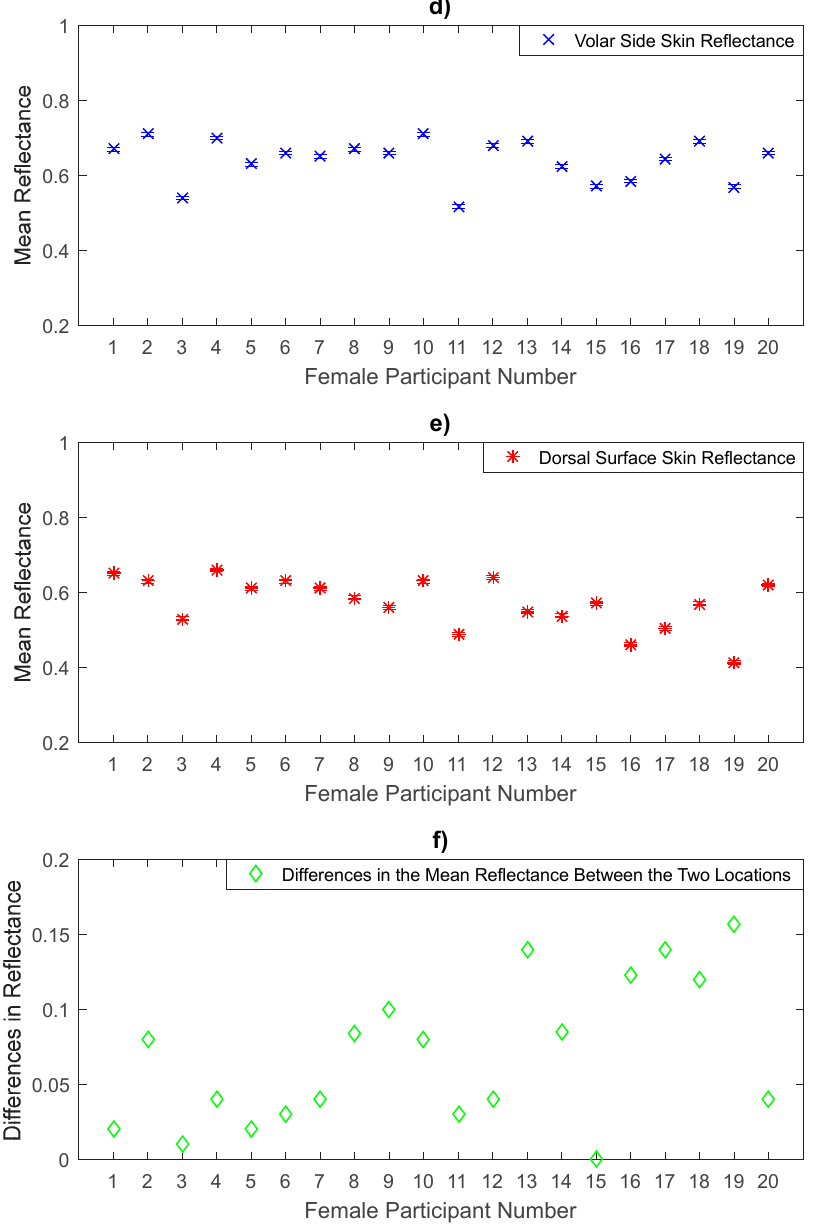
Figure 6. Measurements of human skin reflectance on the volar side ( d ) and the dorsal surface skin ( e ) for a sample of 20 female participants. The mean differences in reflectance values between the two locations ( f ) are in the range of 0 to 0.157.